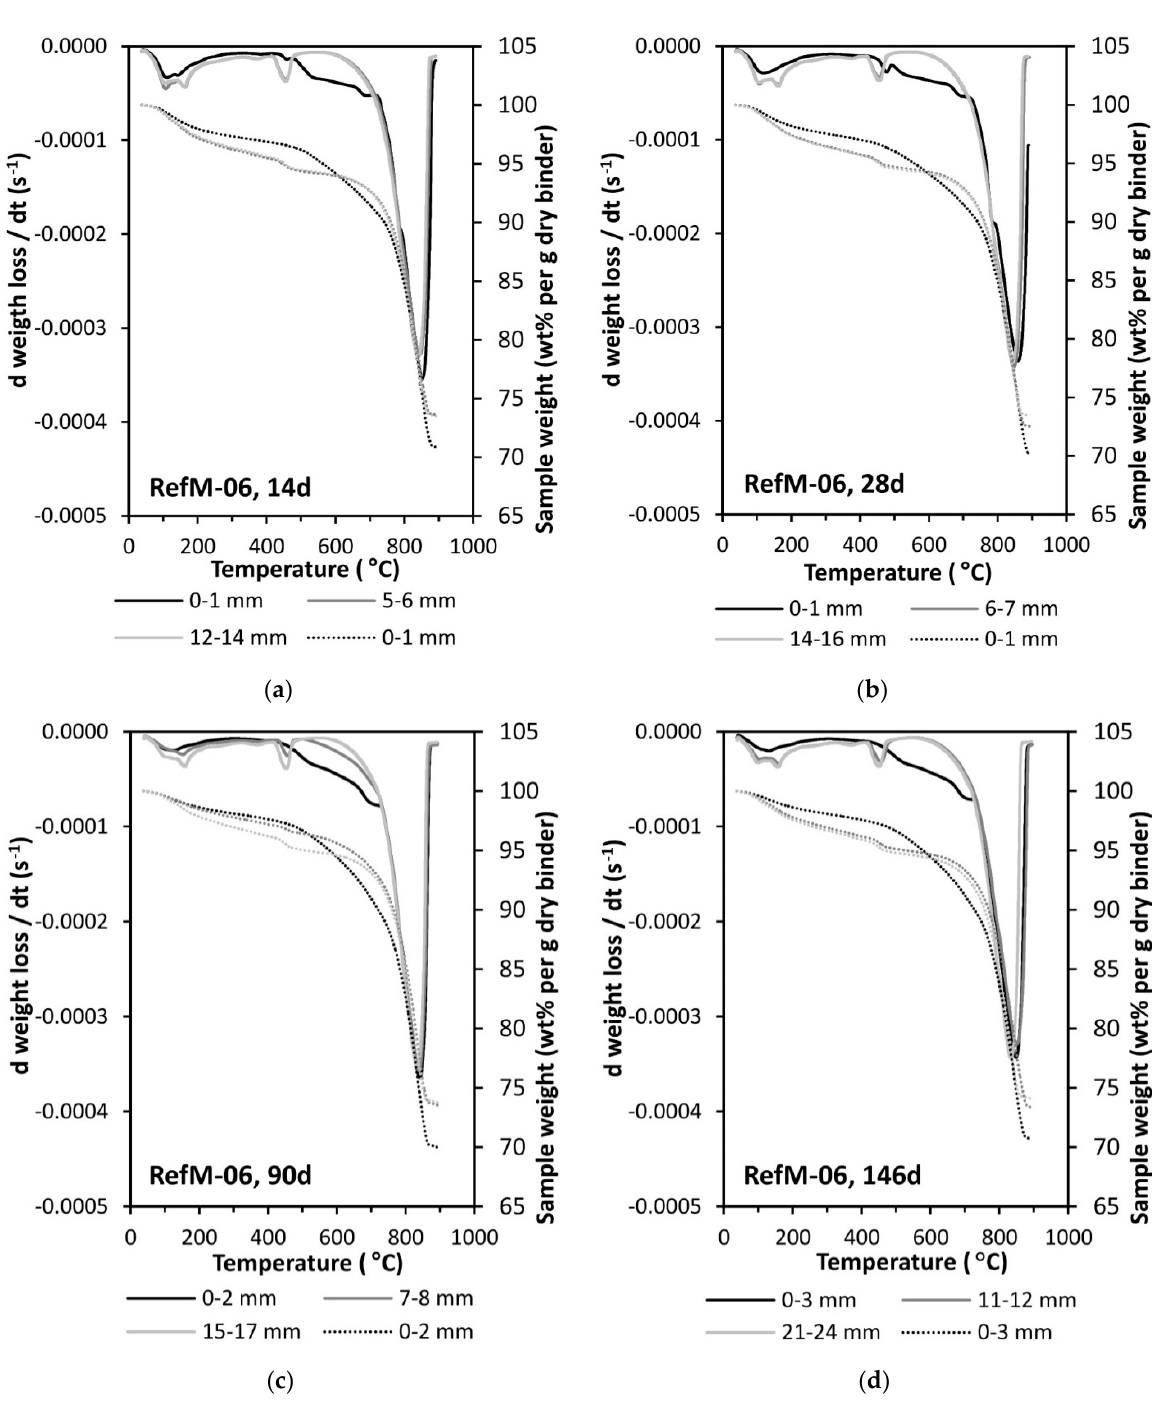
Figure A2. Differential thermal analysis (DTG) results obtained on reference mortar RefM-06 after ( a ) 14, ( b ) 28, ( c ) 90, and ( d ) 146 days of exposure to accelerated carbonation. Extension “-06” refers to the water-cement ratio of 0.6. Each graph shows the results of the top layer in black, the innermost layer in light grey, and one layer in between, in medium grey.